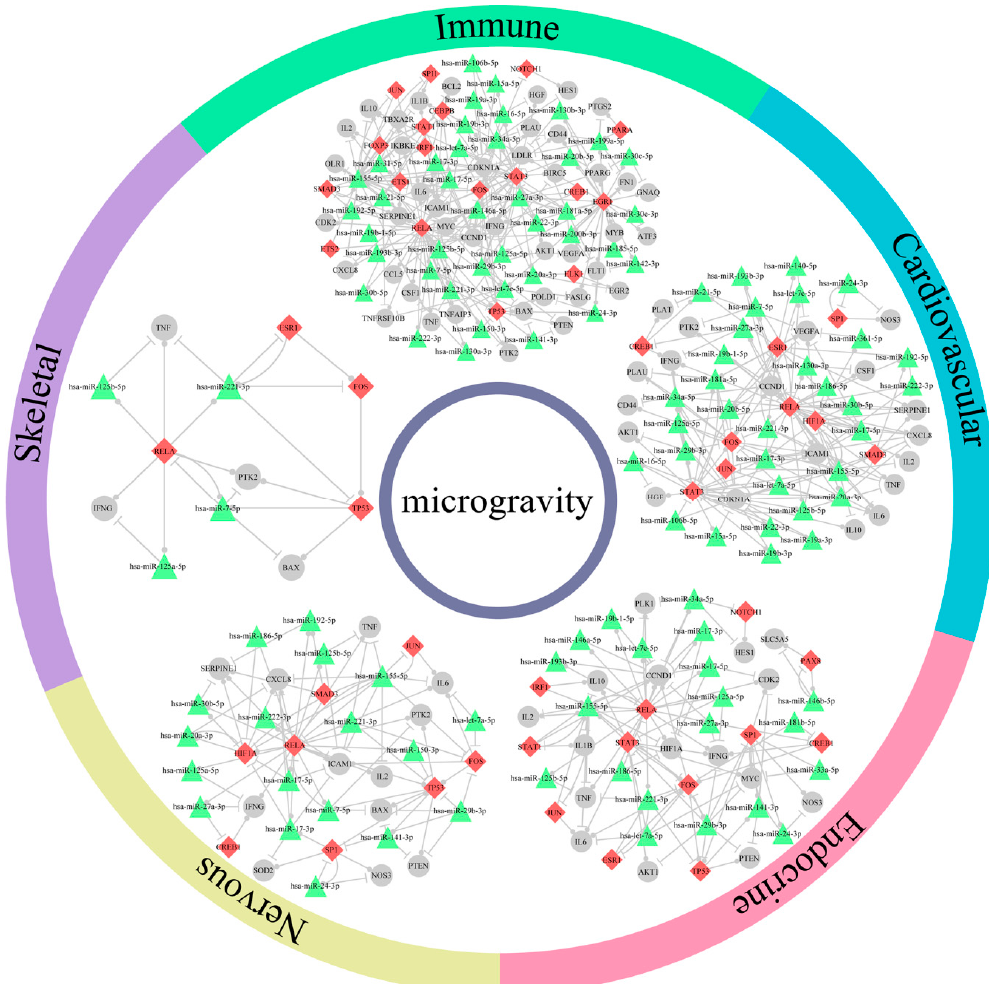
Figure 3. Subnetworks for five human body systems. The red diamond, green triangle and grey circular node represent TF, miRNA and gene, respectively.